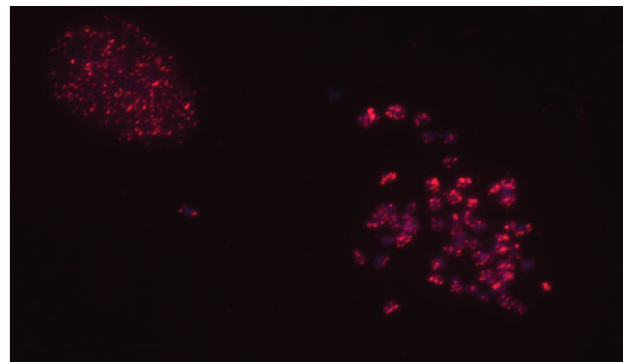
Figure 2. Fluorescent in situ hybridization of genomic distribution of CrERV integrations. Two nuclei of the mule deer cell line [36] are shown, one interphase (left) and the other in metaphase (right). The signal from Alexa Fluor 594 labeled CrERV probe is shown in red, the 4',6-diamidino-2-phenylindole (DAPI)-stained chromosomal DNA in blue. CrERV integration sites appear distributed along each